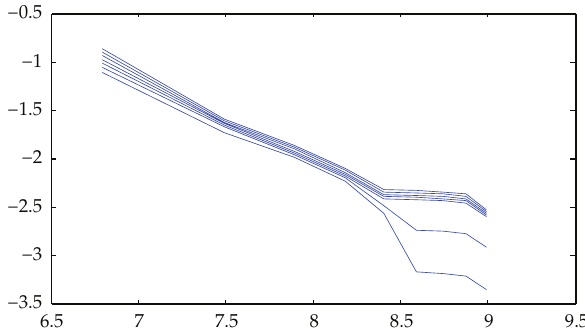
Figure 9: The fitting chart of rehabilitation group for Fugle-Meyer baseline fractal m (cid:8) 2.